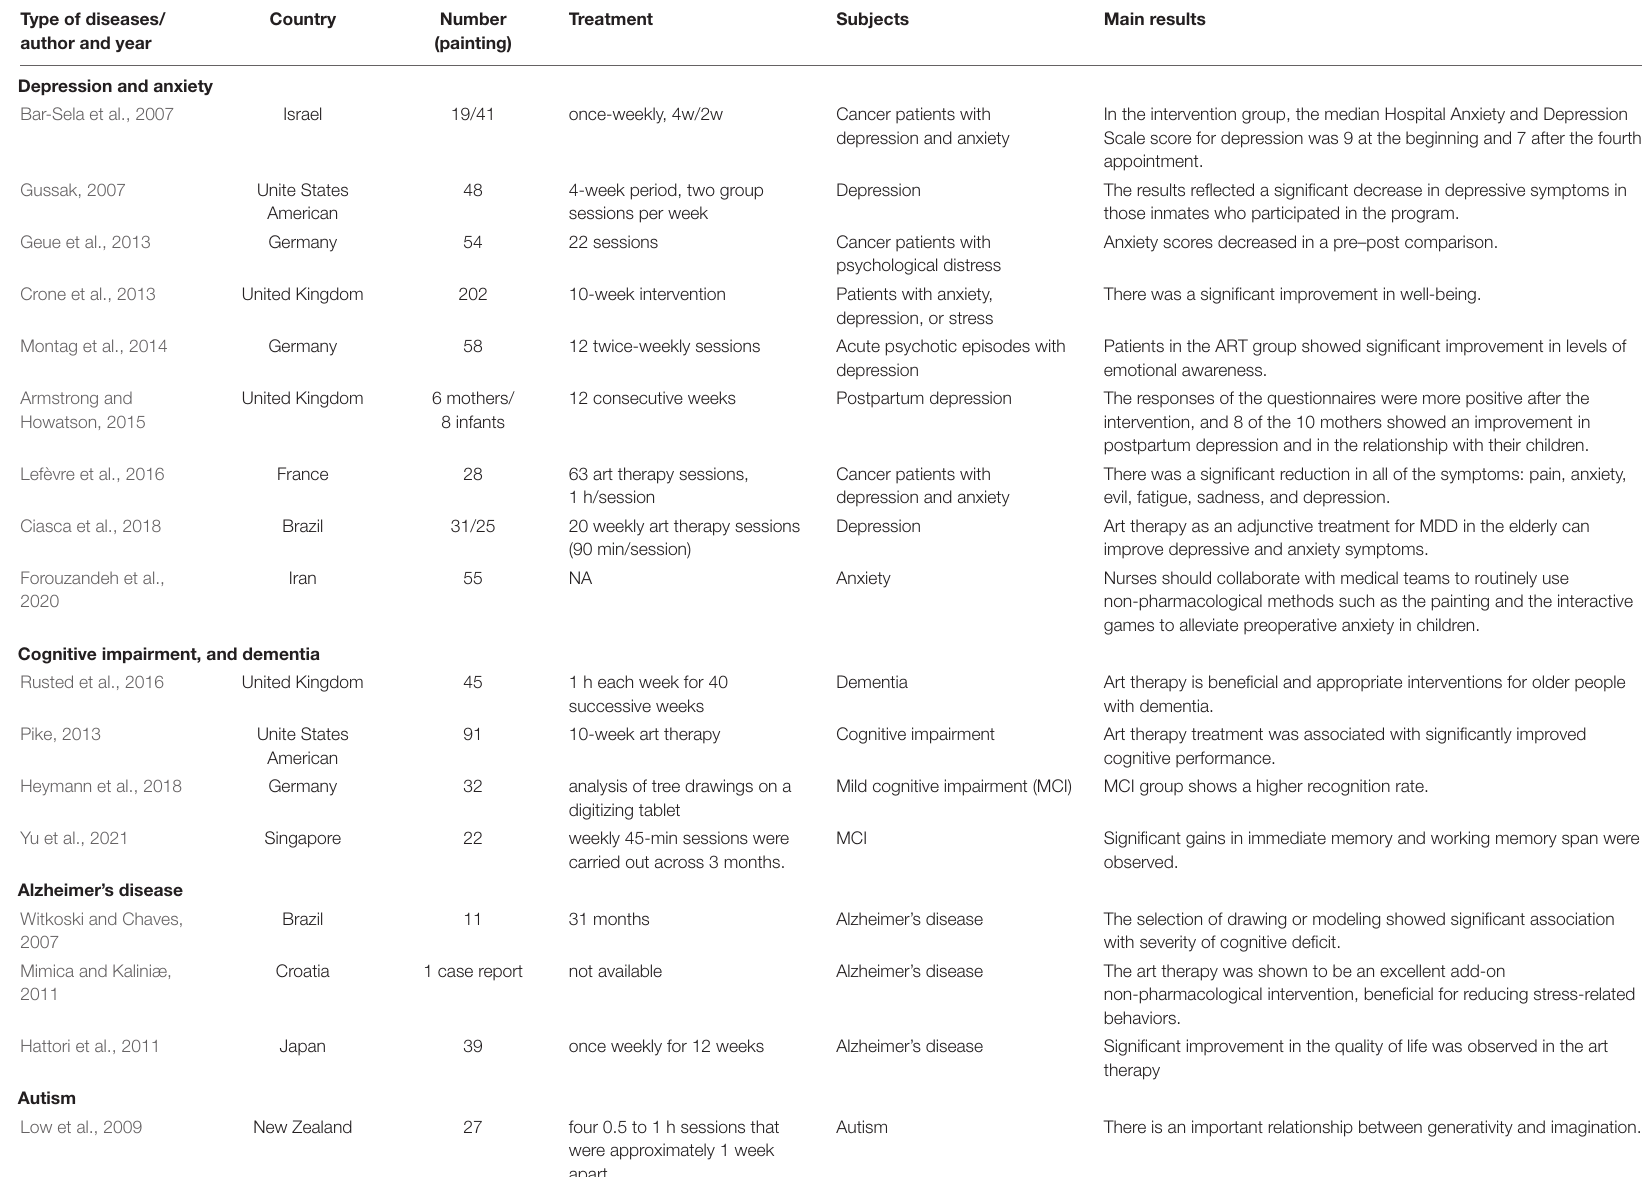
TABLE 1 | Studies of art therapy in mental